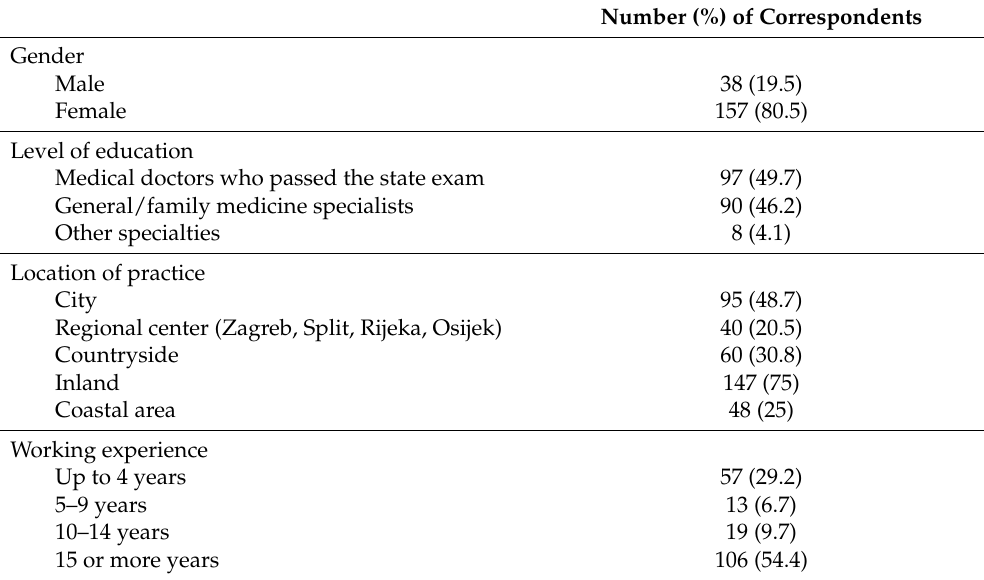
Table 1. Demographic characteristics of